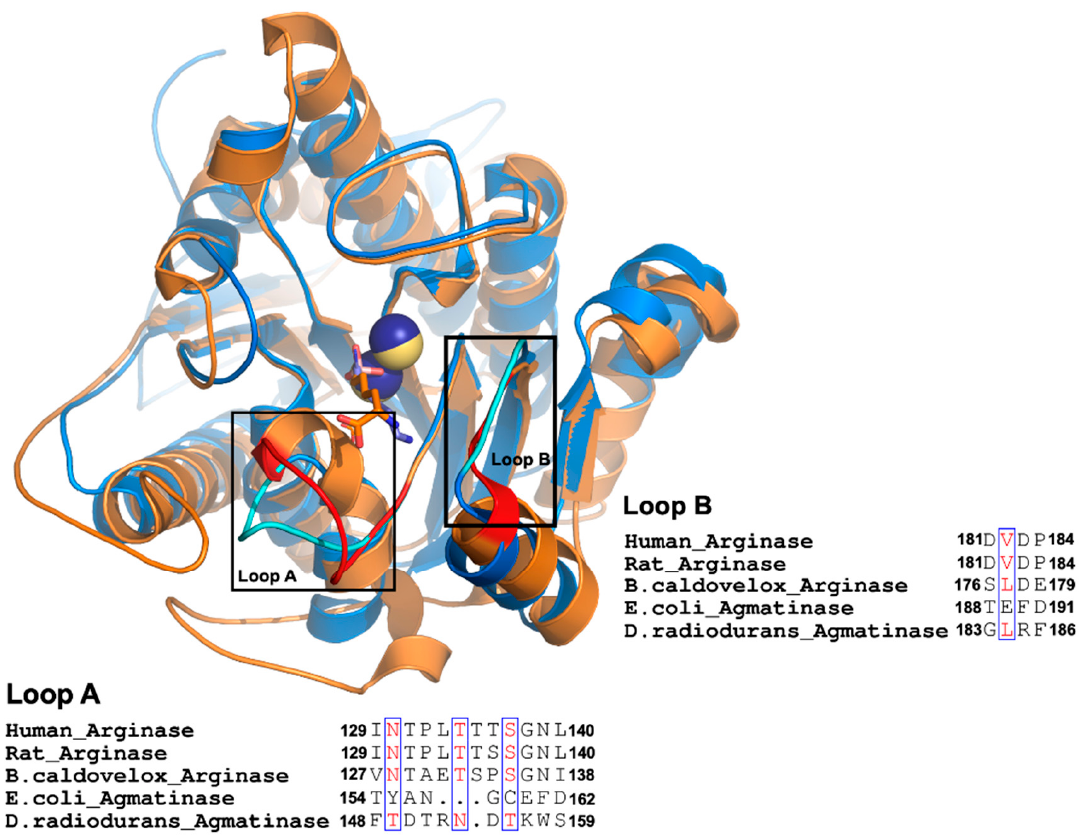
Figure 1. Comparison between agmatinases and arginases. Structural superposition of DrAGM (1WOG) and hARG-I (2AEB). DrAGM and hARG-I are represented in blue and orange, respectively. Loop A and B from DrAGM are shown in cyan, Mn2+ in dark blue, and hexane-1,6-diamino ligand is shown as sticks with blue carbons. Loop A and B from hARG-I are shown in red, Mn2+ ions in yellow, and 2 (S)-amino-6-boronohexanoic acid is shown as sticks with orange carbons. Below each loop has represented the alignment of Loop A and B from agmatinases and arginases.